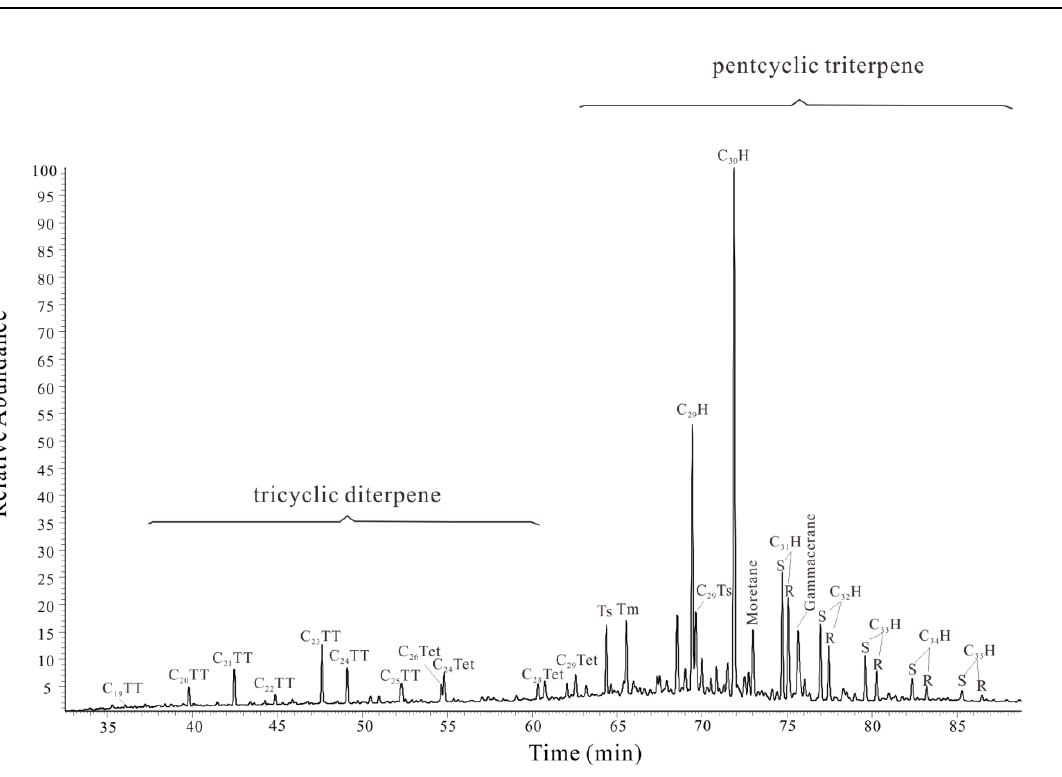
Figure 6. The distribution of terpenoid compound in saturated hydrocarbons of organic material from the representative reservoir bitumen in the Maidiping Member (sample number: XQ18-5) (m/z 191 chromatogram-mass spectrum). Table 2. The biomarker parameters of the reservoir bitumen in the Maidiping Member.